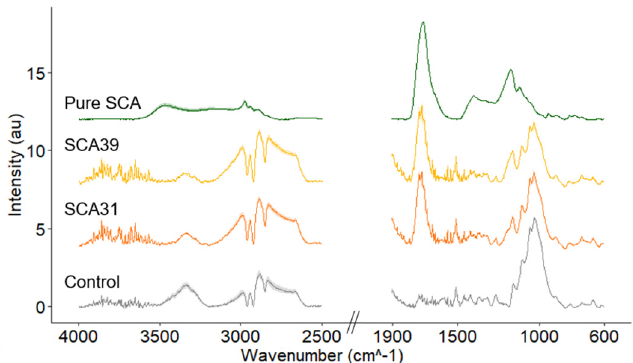
Figure 3. ATR-FTIR spectra of non-leached control wood samples; samples modified with 31% sorbitol citric acid, 39% sorbitol citric acid and pure sorbitol citric acid powder. Solid dark lines represent average spectra for nine replicates for each treatment and lighter shading shows the standard deviation. Note the broken x -axis.